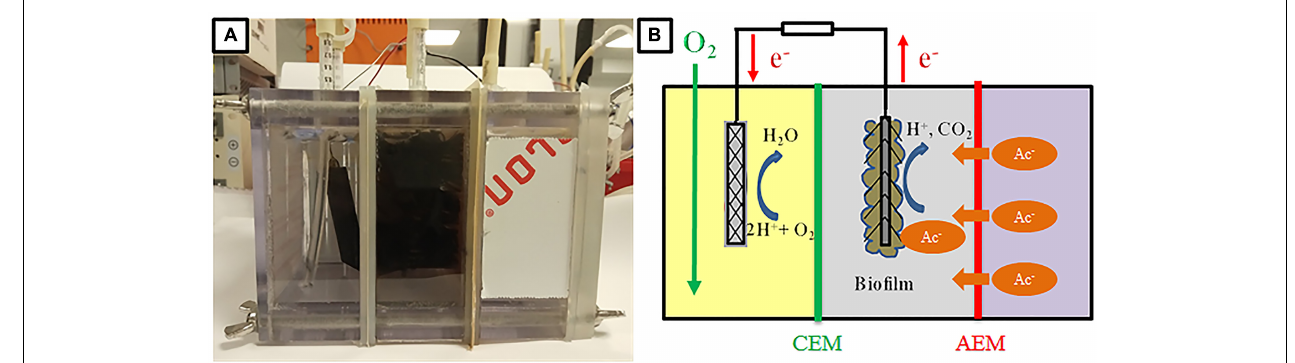
FIGURE 1 | Prototype (A) and schematic diagram (B) of the MFC based